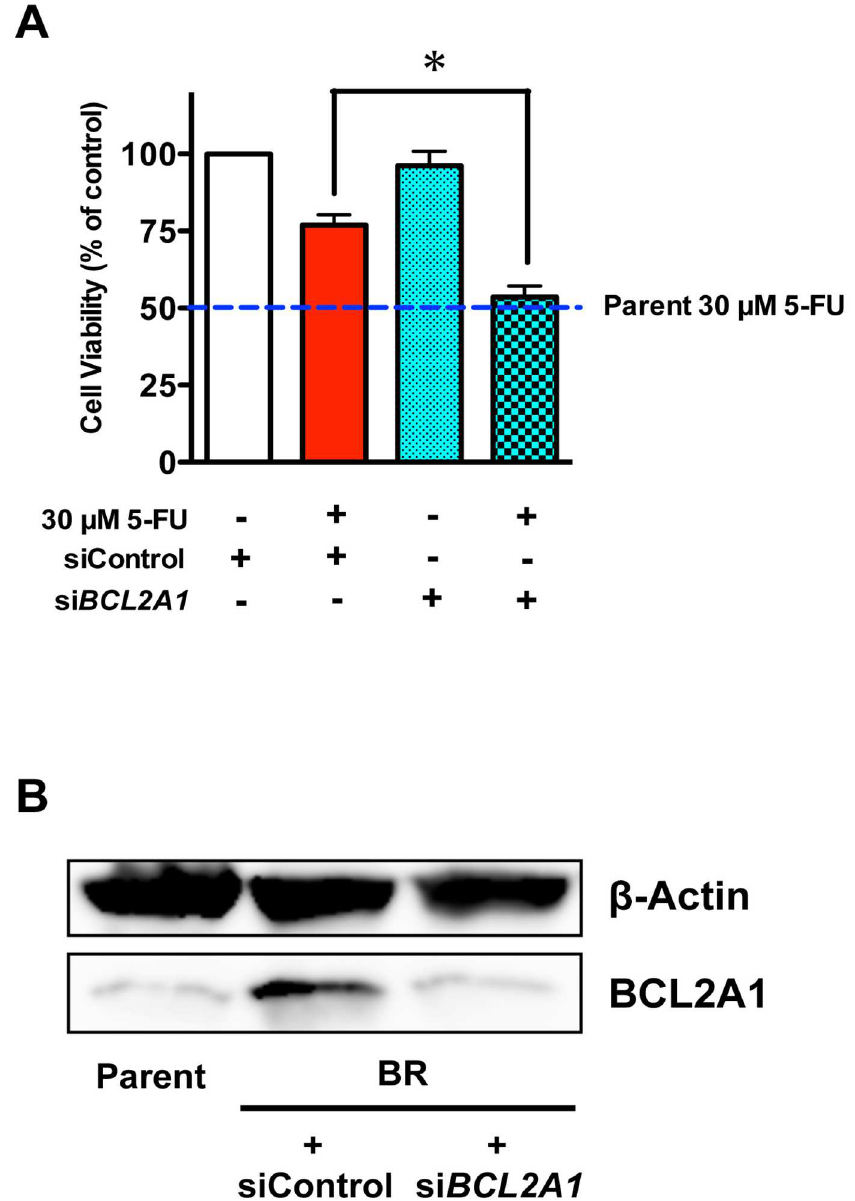
Fig 7. Effect of specific knockdown of BCL2A1 on MDA-MB-231BR. (A) Cytotoxicity of 5-FU to MDA-MB-231BR after transient transfection with BCL2A1 siRNA. Blue broken lines parallelto x-axis represent the cell viability of MDA-MB-231 (Parent) treated with 30 μ M 5-FU. Data represent the mean with SEM of three independent samples ( * P < 0.05, BR treated with 30 μ M 5-FU and siControl vs . BR treated with 30 μ M 5-FU and si BCL2A1 ).(B) Changesin protein expression of BCL2A1 in MDA-MB-231BR in response to BCL2A1